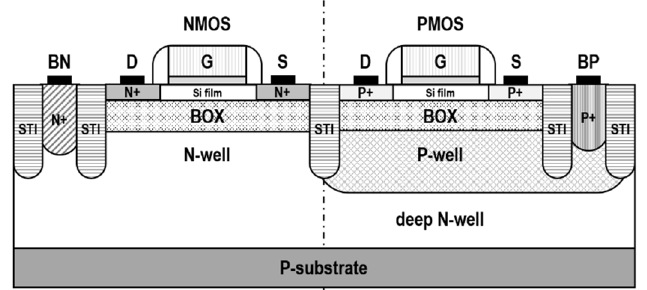
Figure 1. Simplified cross ‐ section of a flipped ‐ well n ‐ type metal ‐ oxide–semiconductor (NMOS) and with p ‐ type metal ‐ oxide–semiconductor (PMOS) transistors. with p-type metal-oxide–semiconductor (PMOS) transistors